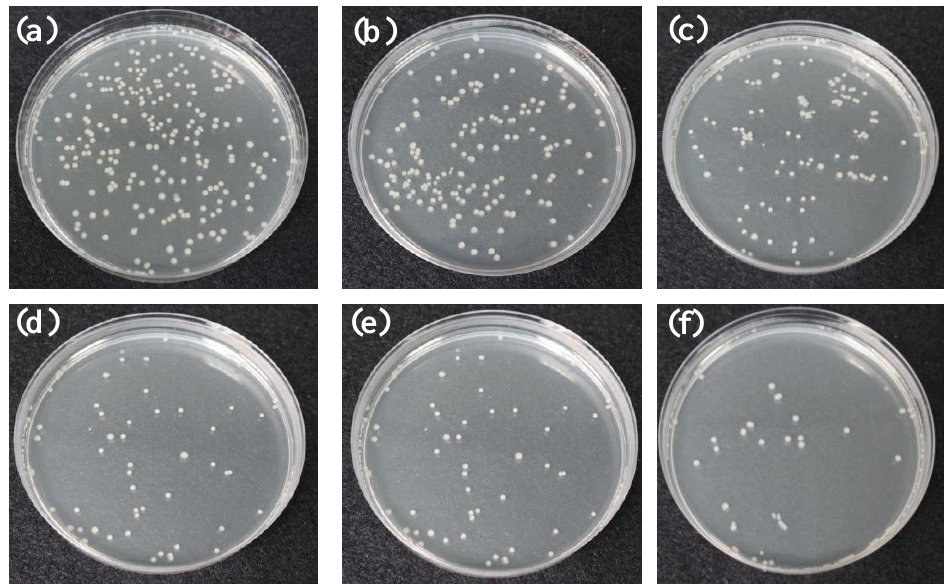
Figure 8. Colony count of functional antibacterial knitted fabrics made of 3-plied twisted yarns: ( a ) 3Zn-0C-K, ( b ) 3Zn-1C-K, ( c ) 3Zn-2C-K, ( d ) 3Zn-3C-K, ( e ) 3Zn-4C-K, and ( f )